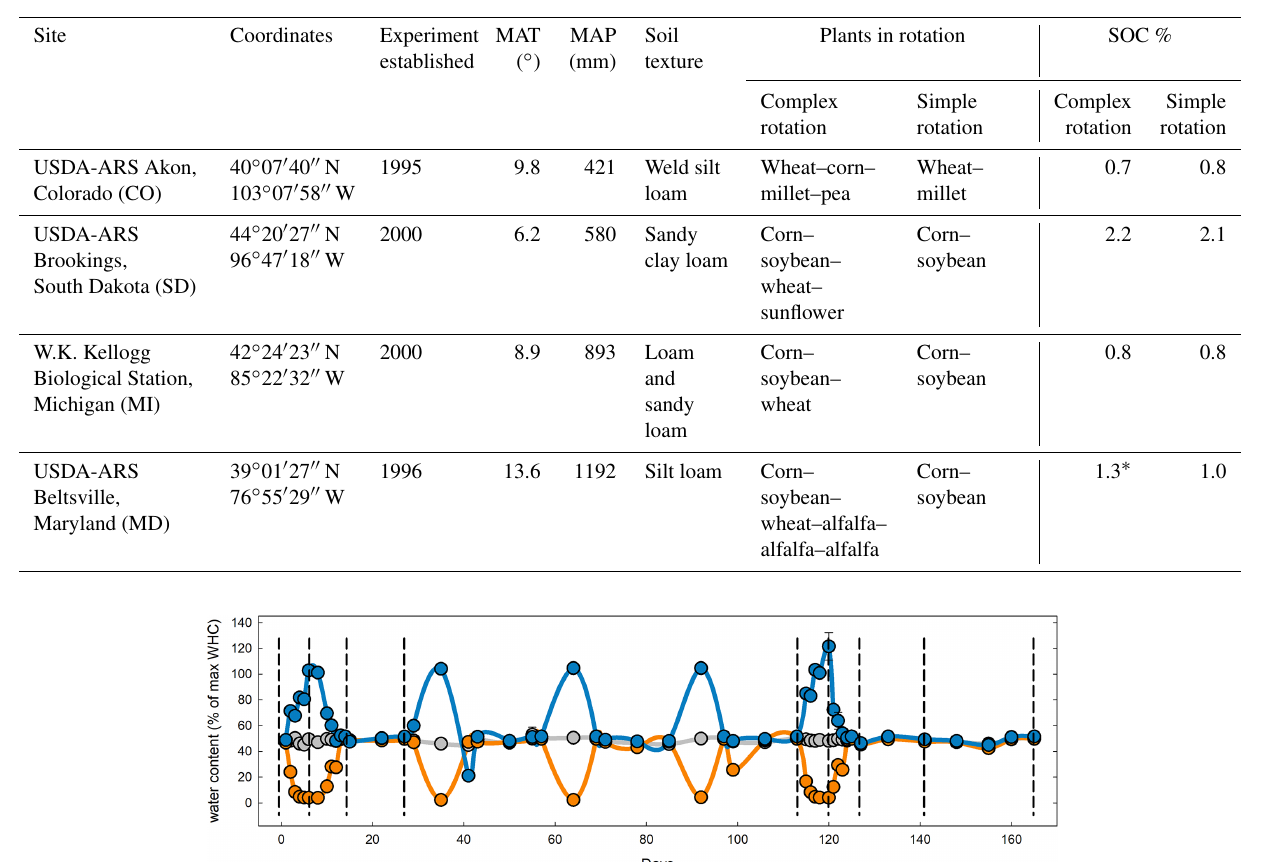
Table 1. Information on the sites used in the laboratory incubation experiment. MAT is mean annual temperature, MAP is mean annual precipitation, and SOC is soil organic carbon content. Asterisks indicate a significant difference between simple and complex rotations.